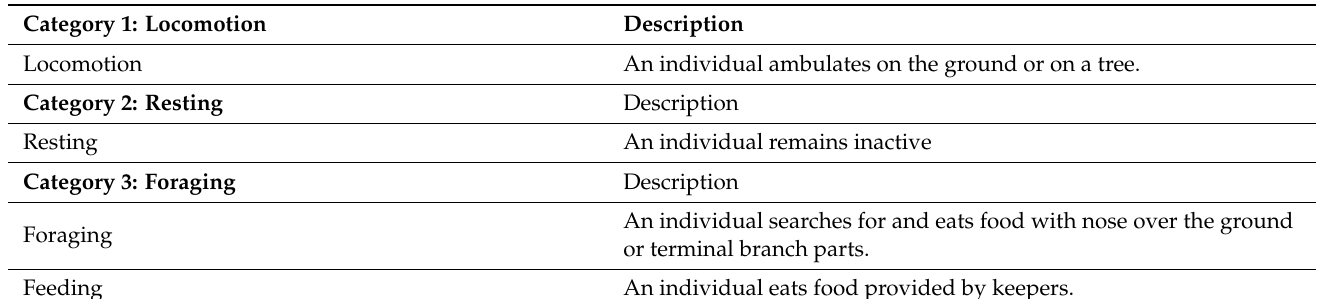
Table 2. Description of the behaviors considered for the present study based on the ethogram of Pereira and Kappeler [46], Maloney et al. [31] and Shapiro [32]. Description An individual ambulates on the ground or on a